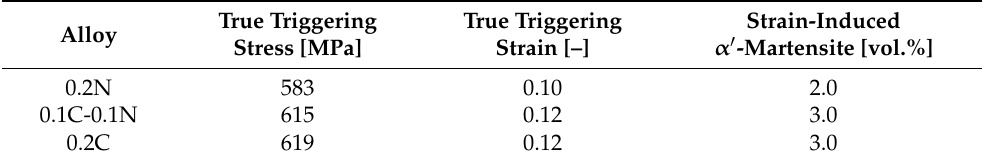
Table 3. True triggering stress, triggering strain, and strain-induced α ´-martensite fraction of the investigated steels in the first IP of the stress–strain curve.